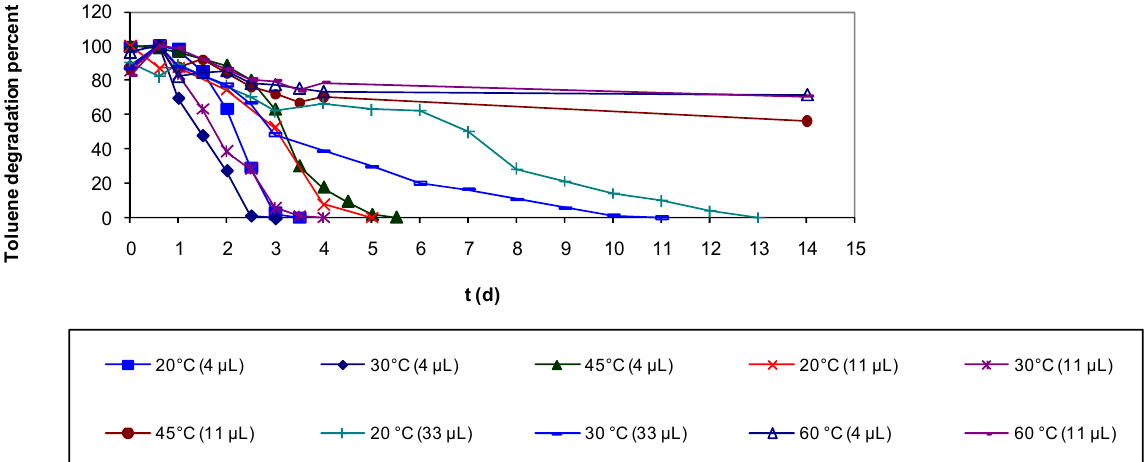
Figure 11. Batch assays at different temperatures and volumes of toluene.